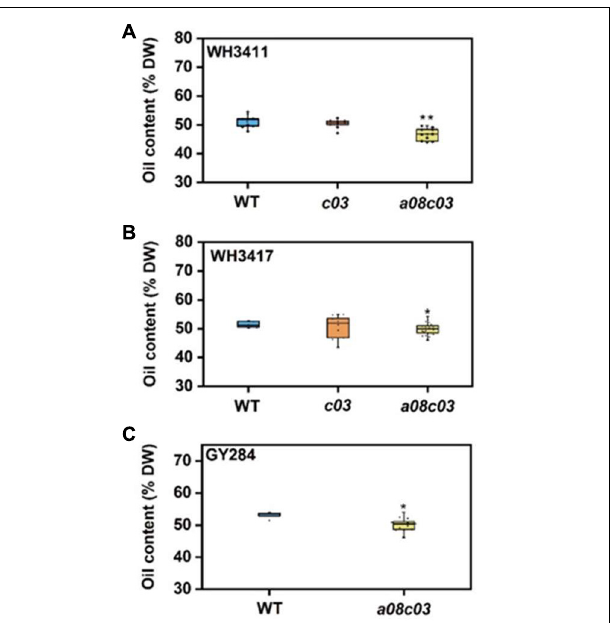
FIGURE 4 | Seed oil content of BnaFAE1 mutants. Seed oil content of WH3411 (A) , WH3417 (B) , and GY284 (C) and their Bna FAE1 mutants was determined by near infrared spectroscopy. c03 represents BnaC03.FAE1 homozygous mutant. a08c03 represents BnaC03.FAE1 and BnaA08.FAE1 homozygous double mutant. Values are means ± SD ( n = 6 ∼ 20). * P ≤ 0.05; ** P ≤ 0.01.